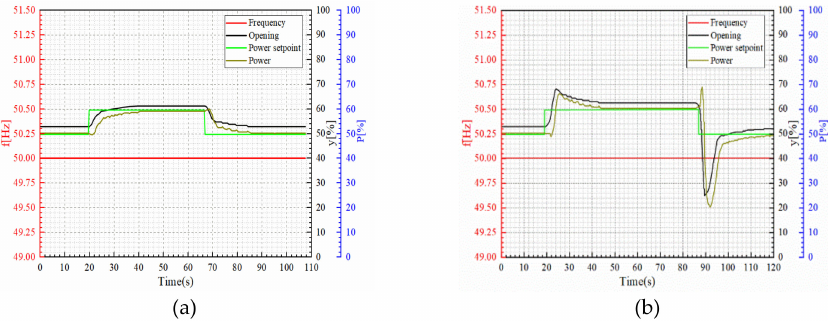
Figure 9. Power regulation with 10% rated power change. ( a ) The S-curve control strategy; ( b ) The conventional linear control strategy.